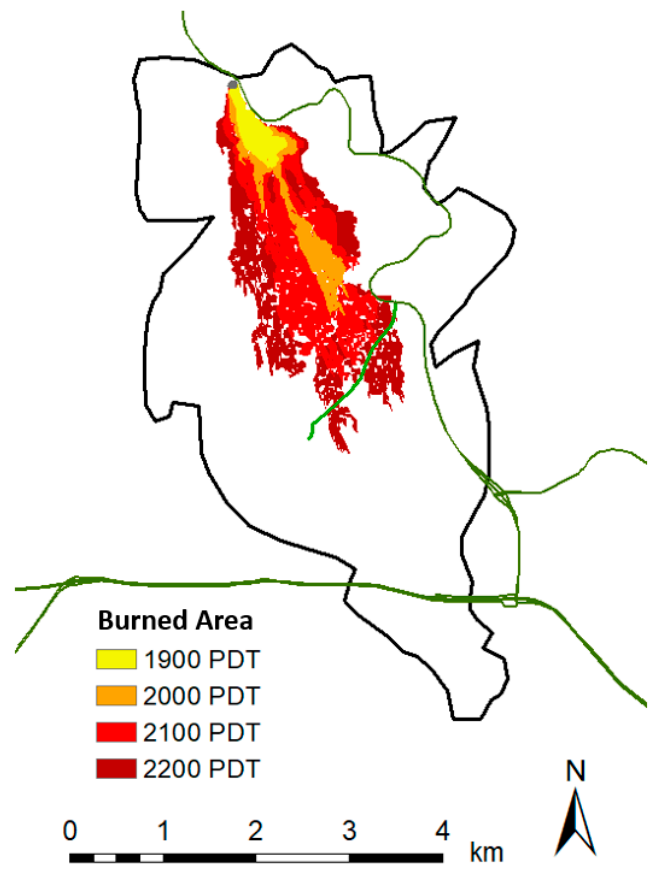
Figure A2. Same as Figure 7c using the original fuel map (shown in Figure 2c).